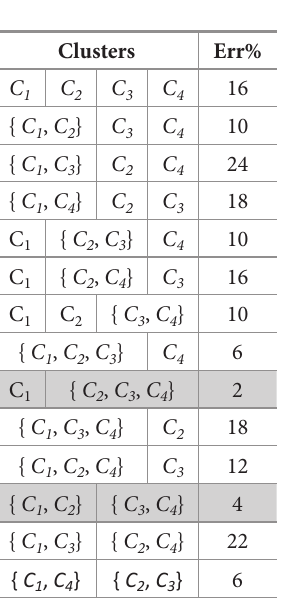
Table 1. Cluster combination classification errors for each class using C4.5. Best result lines are shaded Class Iris-Setosa Class Iris-Versicolor Class Iris-Virginica Clusters Err% Clusters Err% Clusters